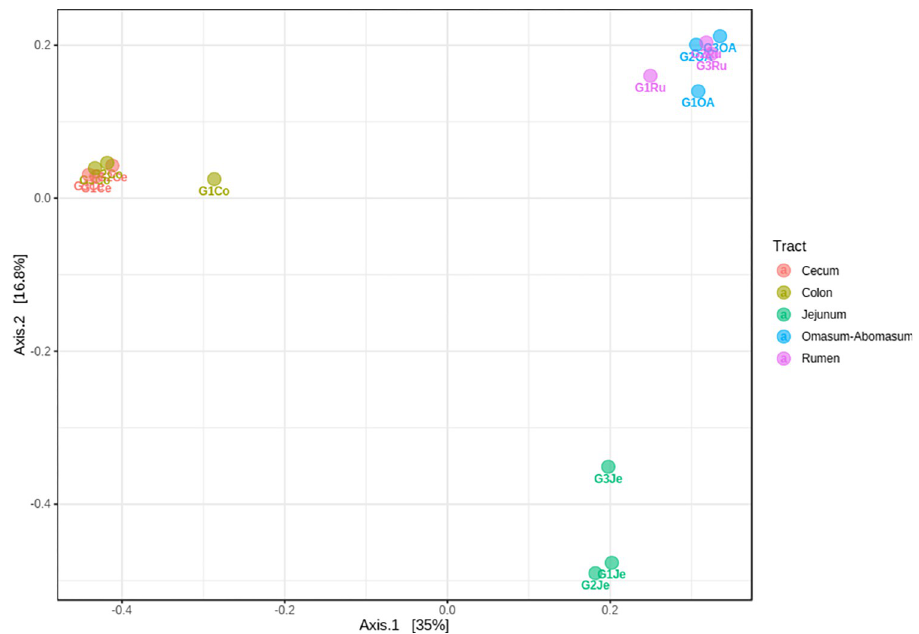
Fig 2. Comparison of the bacterial diversity present in the Capra hircus GITs. The differences among samples were based on the relative abundance of OTUs. Ru: rumen; OA: omasum + abomasum; Je: jejunum; Ce: cecum; Co: colon; G: